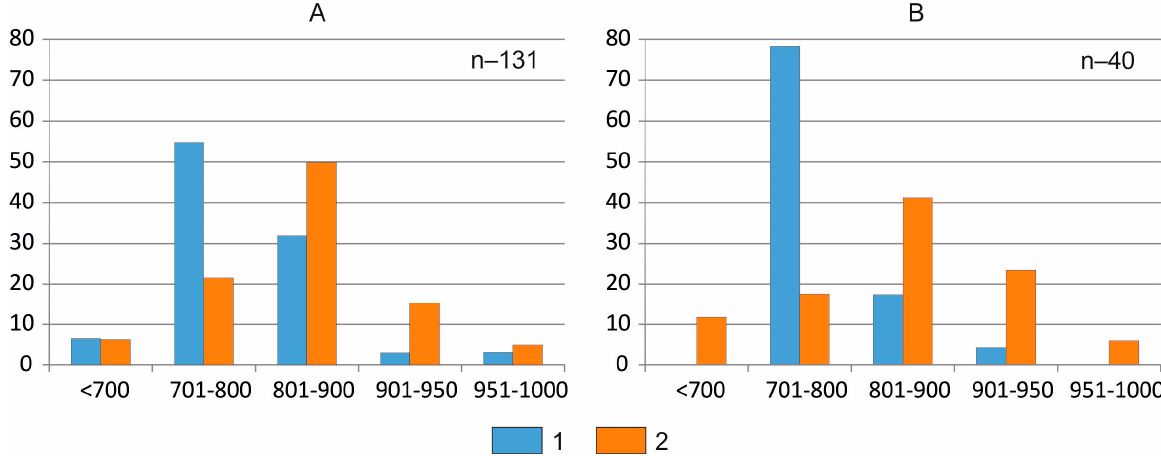
Figure 9. Histograms for the distribution of the fineness of gold: ( A )—native gold, ( B )—supergene gold. 1—Spokoinoe ore field, 2—Mayskoe ore field, n—number of analyses.